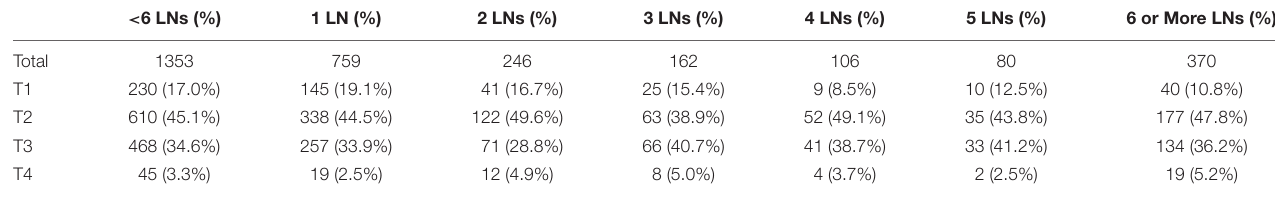
TABLE 3 | Patient distributions stratified by the number of LNs